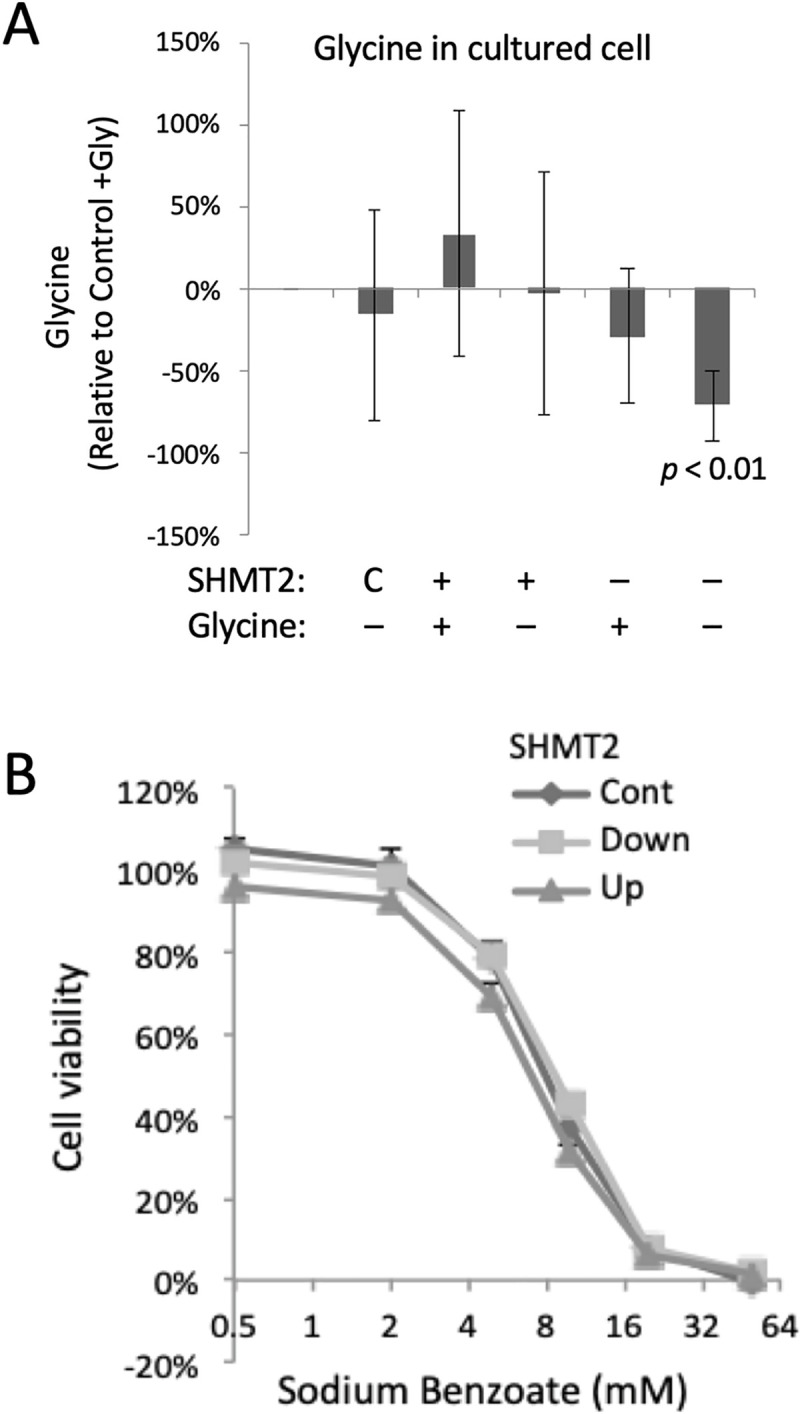
Analysis of glycine and proliferation in vitro as a function of SHMT2 and sodium benzoate.HeLa-Ss cells were grown in normal media under SHMT2 Tet induction (Up) or IPTG knock-down (Down) treatment for 72 h. Intracellular metabolites were extracted and analyzed by selected reaction monitoring mass spectrometry, SRM, n = 5 to 8 biological replicates. (A) In HeLa-Ss cells relative levels of intracellular glycine levels were measured as a function of endogenous SHMT2 expression (control; C) or elevated (+) or decreased (–) expression of SHTM2 (described above), and without (–) or with (+) glycine supplementation in growth medium. (B) HeLa-Ss cell viability as a function of sodium benzoate concentration as indicated in uninduced cells (control, cont) or following induction of ectopic SHMT2 (Up) or knockdown of SHMT2 expression (Down).